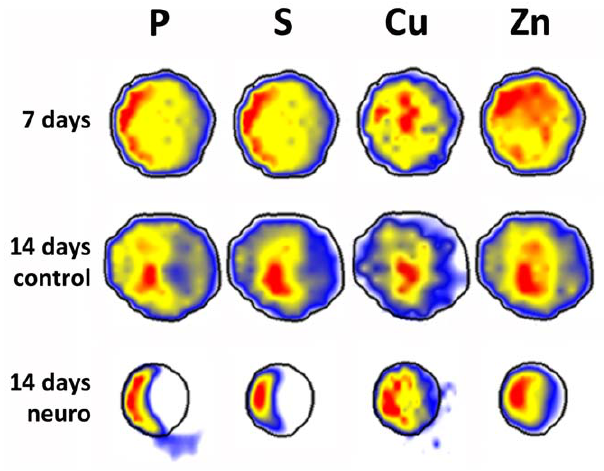
Figure 9. Atomic distribution within human embryoid bodies. Top line: 7 days old H9 embryoid body; Middle line: 14 days old control H9 embryoid body; Bottom line: 14 days old neural induced H9 embryoid body. Elements are shown on the top line above the heat maps. Maps are representative of all samples. Bright field images scale bar: 50 m